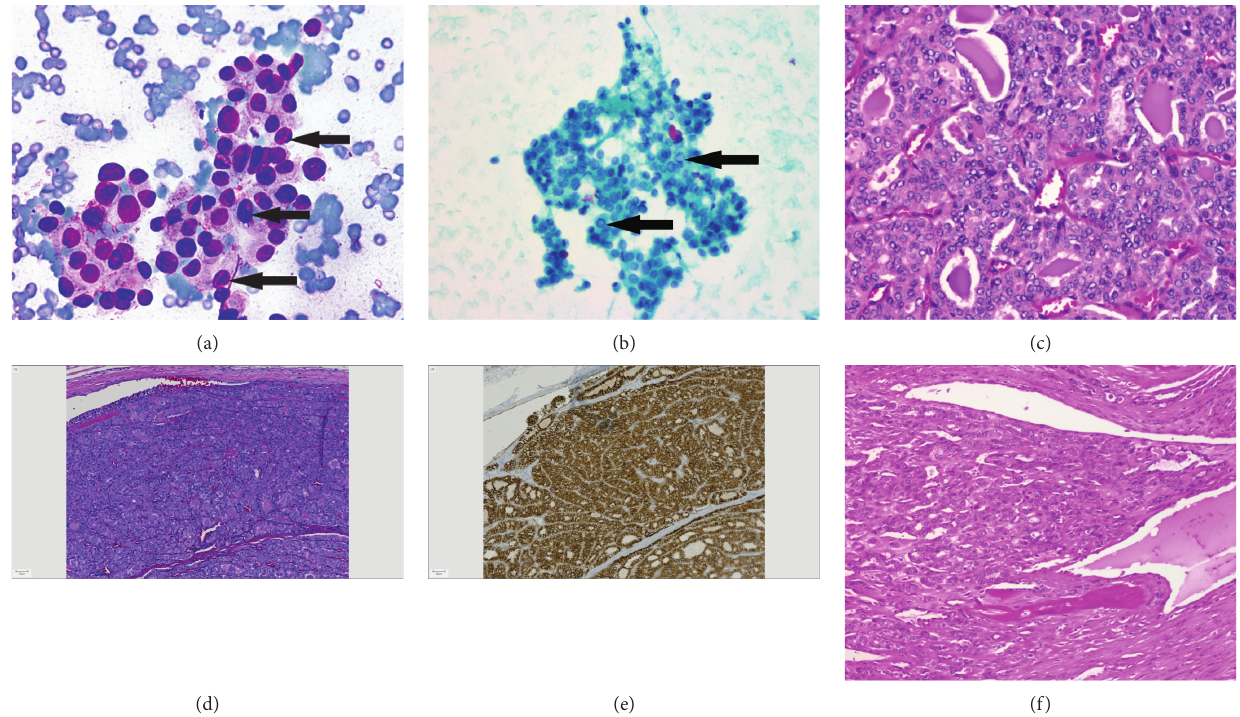
Figure 5: Papillary thyroid carcinoma. (a) Fine-needle aspirate of the right side neck mass showing abundant clusters of neoplastic thyroid tissue, and nuclear grooves (arrow) are present (Diff Quick stain, 200x). (b) Cluster of neoplastic thyroid tissue from the neck mass with focal pseudoinclusions (arrow) in nuclei (PAP stain, 200x). (c) Histologic sections of the right side neck mass showing thyroid carcinoma with papillary nuclear features (nuclear overlap, nuclear grooves, and nuclear clearing), consistent with papillary thyroid carcinoma (H&E stain, 200x). (d) Histologic sections of the thyroid mass in the right lobe showing papillary thyroid carcinoma (H&E stain, 100x). (e) Im- munohistochemistry for beta-catenin staining showing no evidence of nuclear staining corresponding to the section of the thyroid mass in D (immunohistochemical stain, 100x). (f) Papillary thyroid carcinoma (follicular variant) involving clavicle (H&E stain,